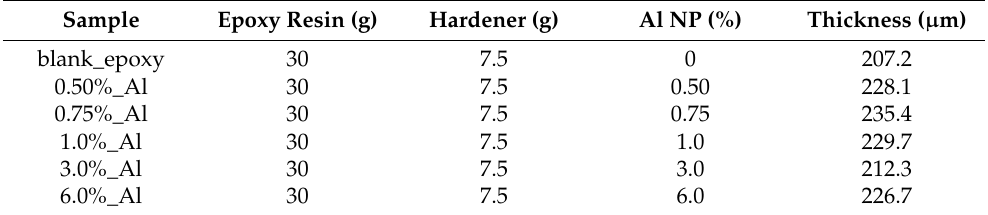
Table 1. Incorporation of aluminium nanoparticles in epoxy resin and thickness of the obtained